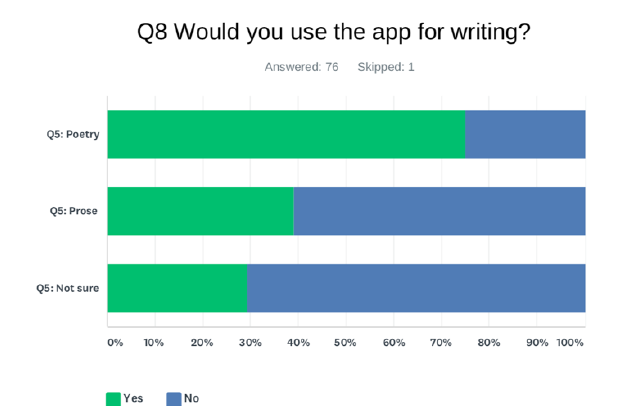
Figure 7. Question 8 split by scores to “Q5. Which do you prefer, poetry or